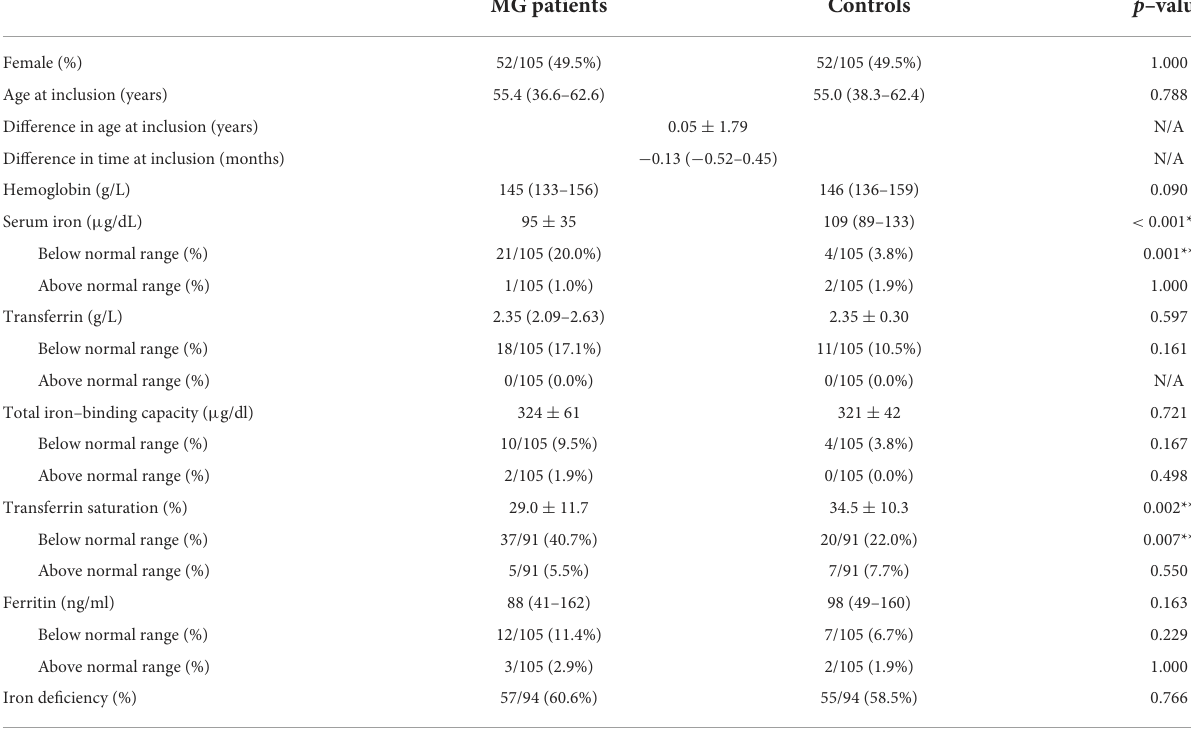
TABLE 1 Baseline characteristics and iron metabolism parameters of patients with MG and